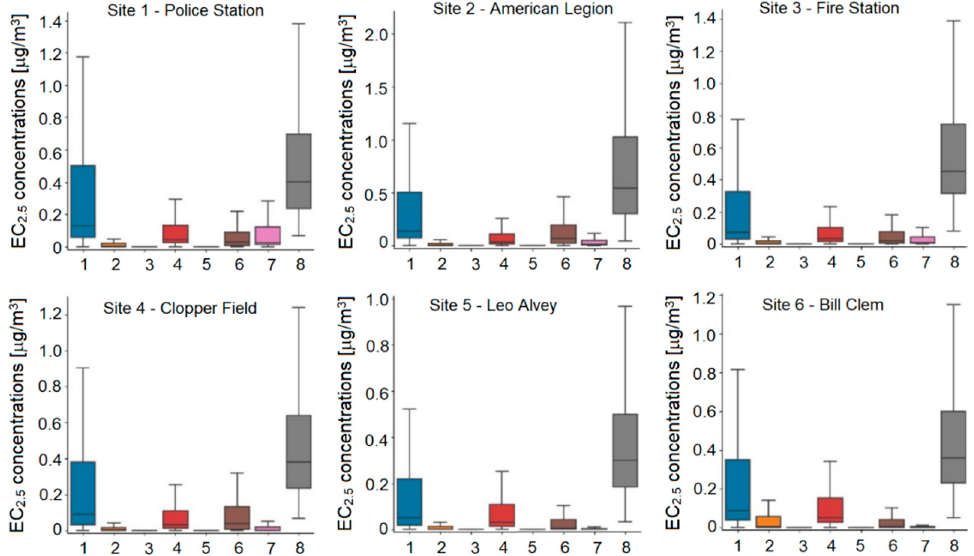
Figure 7. Comparison of distributions of modeled EC 2.5 concentrations at six monitoring locations